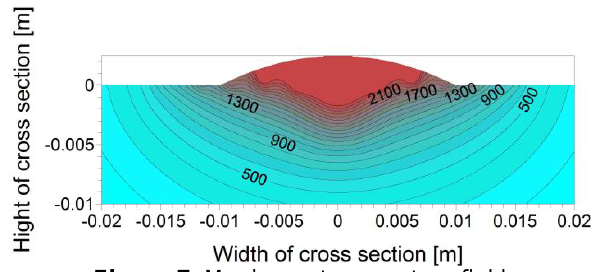
Figure 7. Maximum temperature